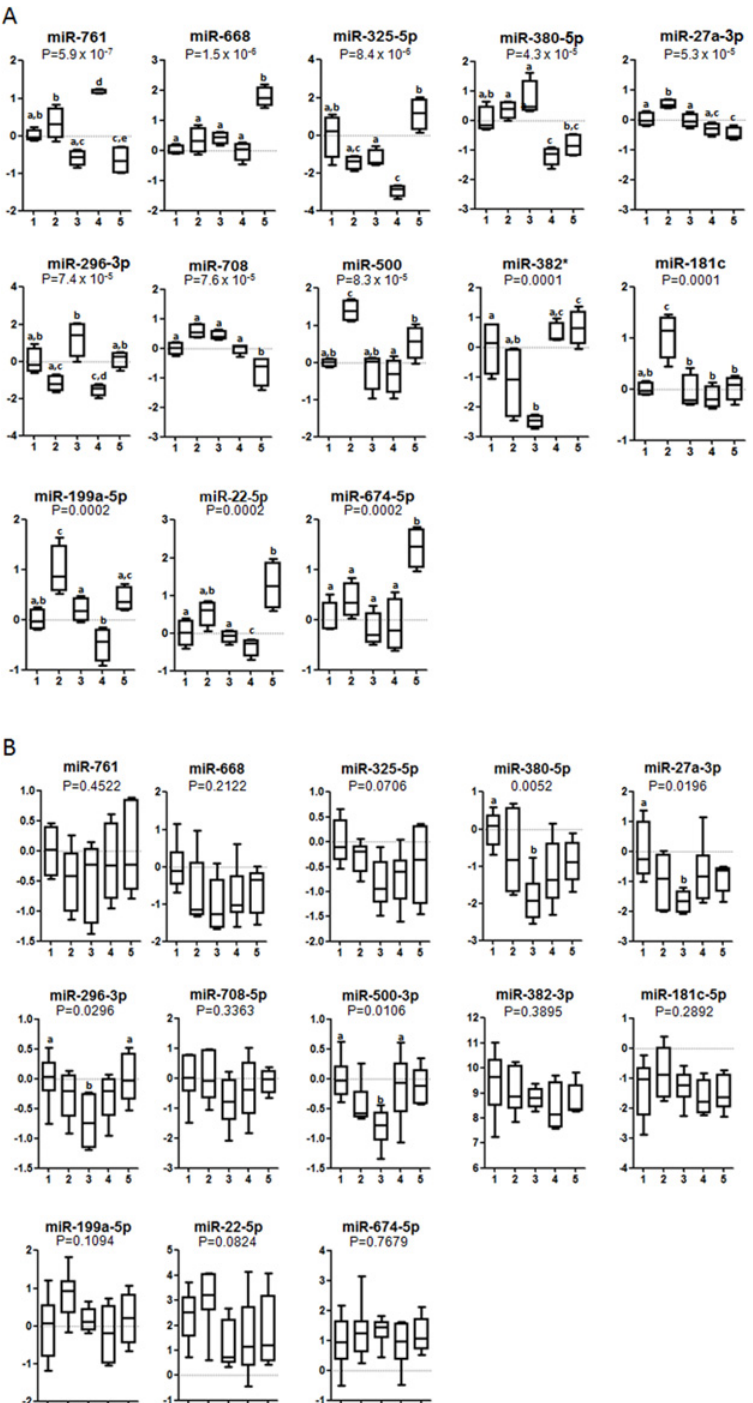
Fig 2. Expression levels of microRNAs in pregnant (A) and virgin (B) rats in lumbar adipose tissue according to the dietary treatment during 12 days. Data is expressed as fold change (mean ± SD) relative to SO diet group. SO diet, 1; OO diet, 2; FO diet, 3; LO diet, 4; PO diet, 5. Different letters in the same graph means statistical difference (P < 0.05) between dietary groups. Animals per group, in (A) n = 4. In (B): SO (n = 6), OO (n = 7), FO (n = 7), LO (n = 6) and PO (n =